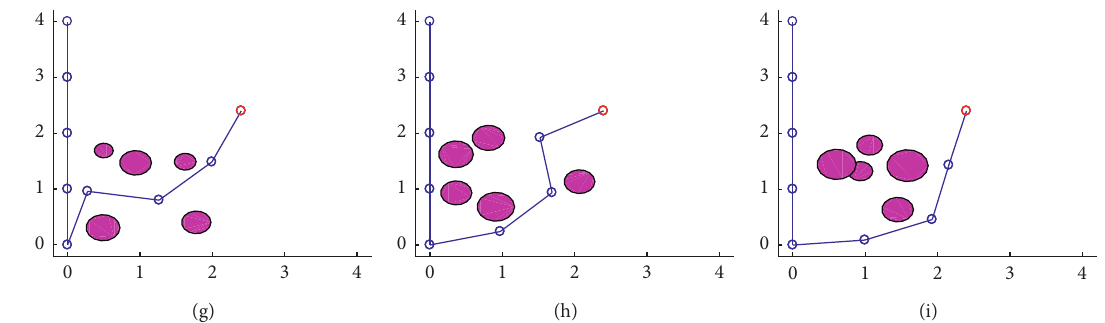
Figure 4: Visualization experiment results of extending FABRIK with obstacle avoidance in test 2.